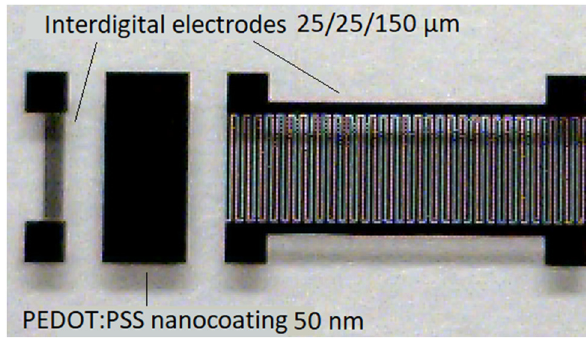
Figure 1: Microscopic image of the part of the SAW sensor with PEDOT:PSS sensing